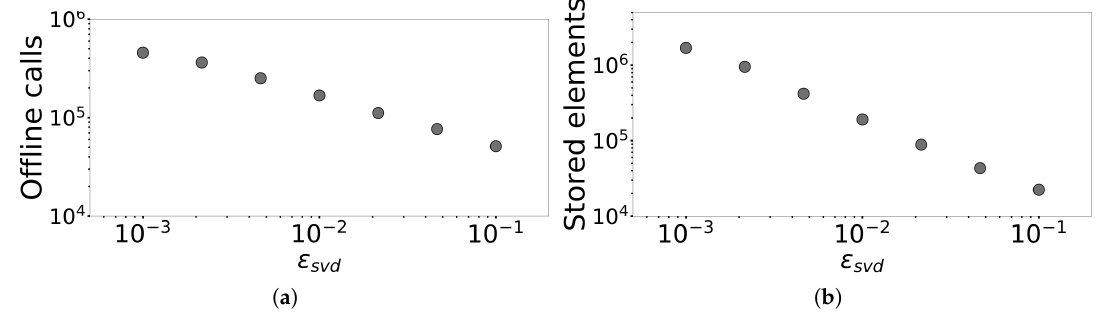
Figure 7. Dependence of computational cost and memory storage indicators on (cid:101) . ( a ) Dependence of the number of calls to the physical model on (cid:101) ; ( b ) Dependence of the number of stored elements on (cid:101)